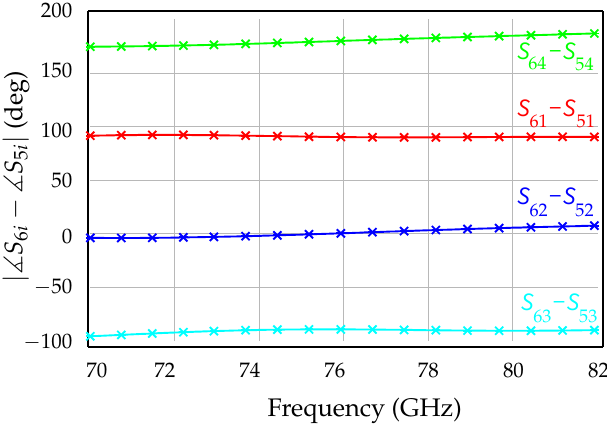
Figure 6. Measured transmission phase between the output ports.